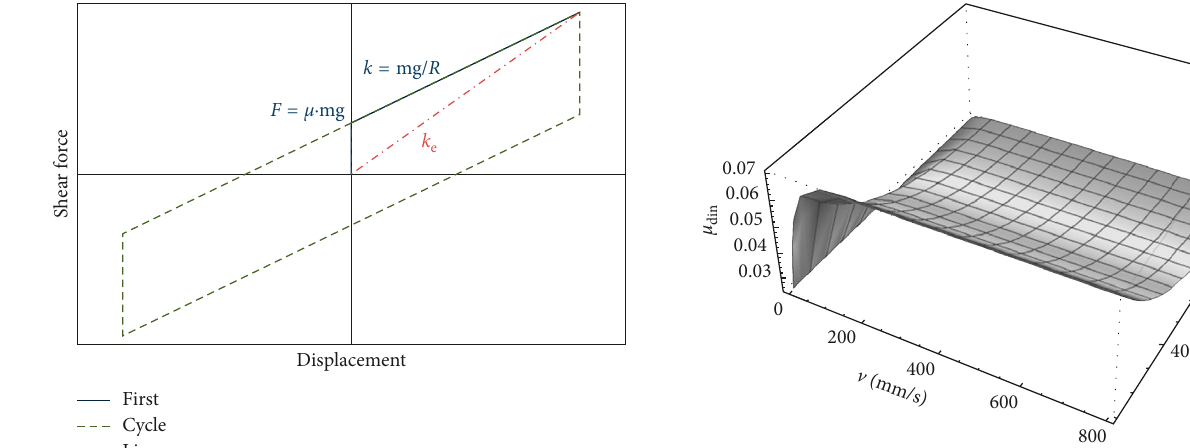
Figure 5: Ideal bilinear force-displacement diagram of a